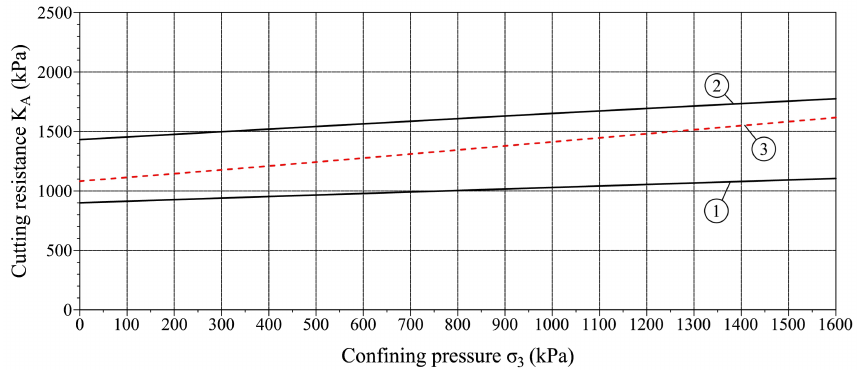
Figure 20. Relationship between cutting resistance, K A , and confining stress, σ 3 ( σ 3 = 400, 800, 1600 kPa) (1—lowest value of K A , 2—highest value of K A , 3—empirical relationship K A = σ 1 /10).